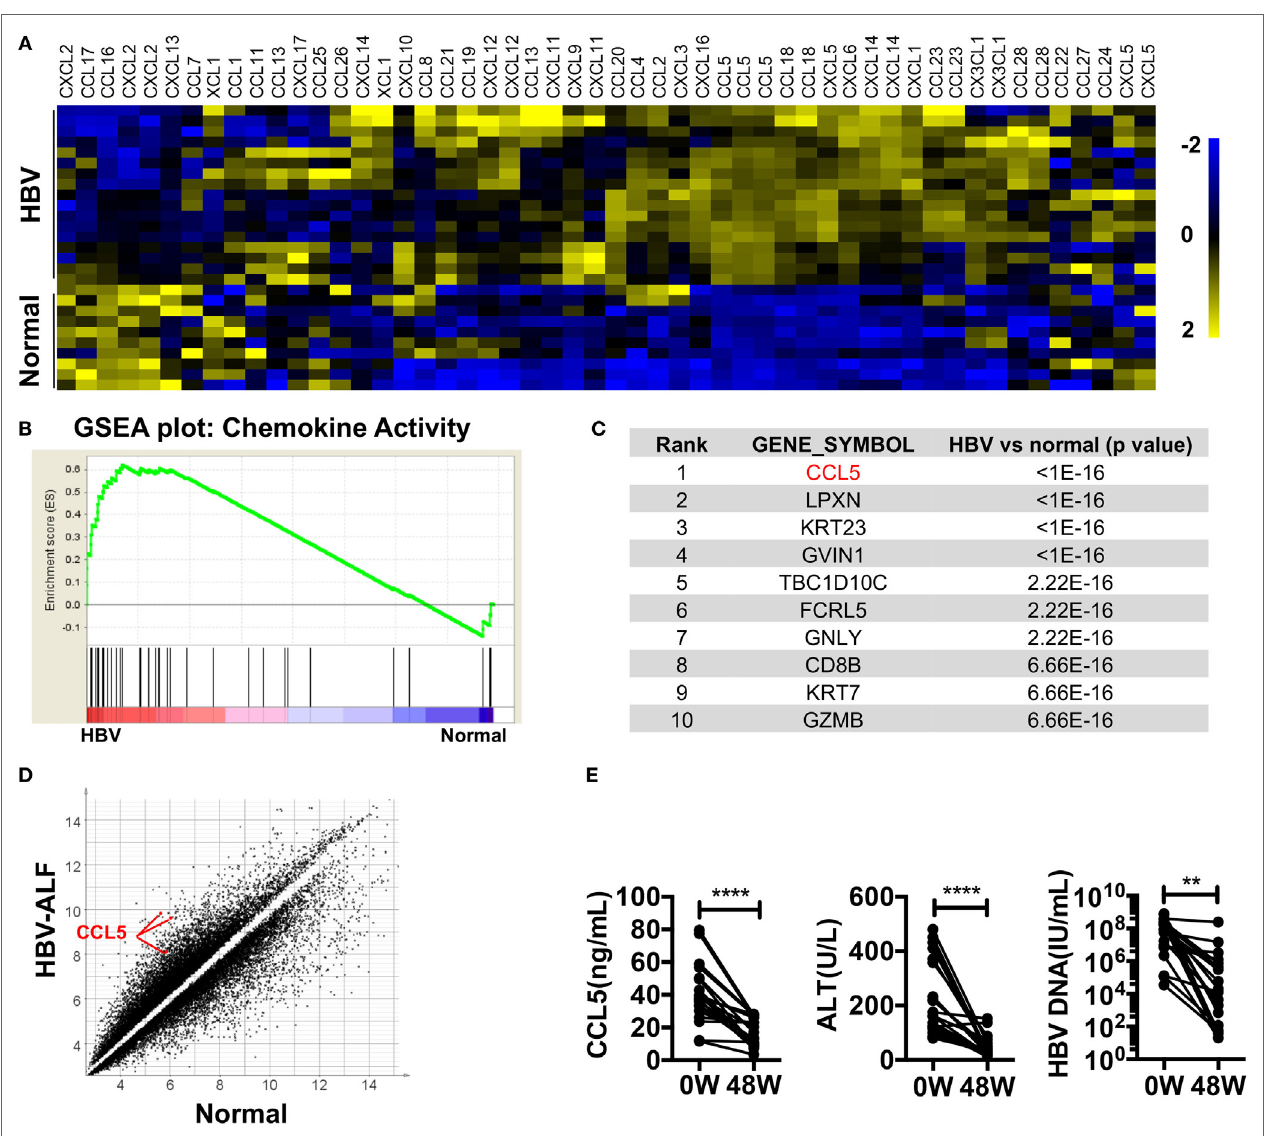
FigUre 1 | chemokines, especially ccl5, are highly expressed in the livers of patients with hBV-associated disease . (a) Heat map of chemokine expression in GSE38941. These data were normalized with MeV. (B) GSEA of the chemokine activity gene set in GSE38941. (c) Genes with top-ranking p -values from Student’s t -tests comparing the expression profiles of liver samples from HBV-associated ALF patients with those of healthy donors. These data were derived from GSE38941. (D) Scatter plot of genes with p -values less than 0.01 in (a) . Three CCL5 probes are indicated. (e) The levels of CCL5, ALT, and HBV DNA were measured in the serum of patients with hepatitis B. 0 W, serum samples before antiviral treatment; 48 W, serum samples after 48 weeks of antiviral treatment ( n =